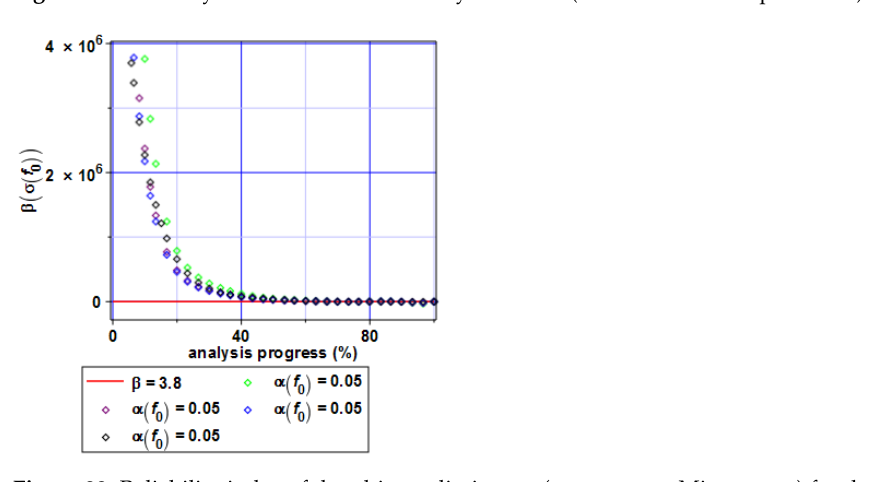
Figure 28. Reliability index of the ultimate limit state (extreme von Mises stress) for the beam.